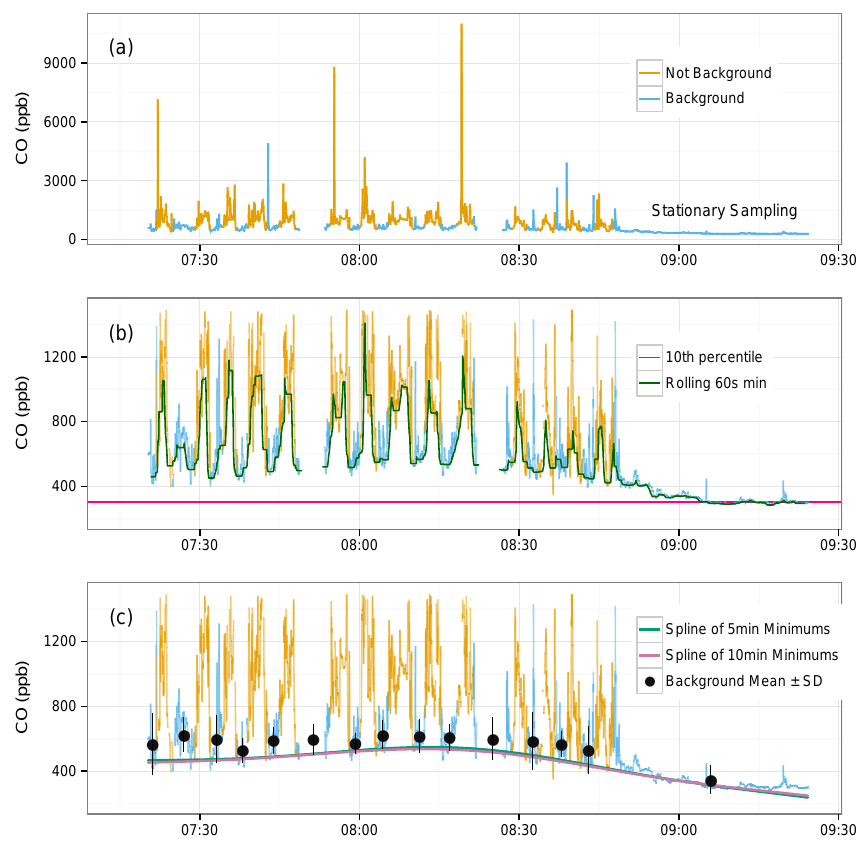
Figure 5. Background estimation methods: (a) example time series; (b) time series methods: running minimum and 10th percentile; (c) location-based method (mean and standard deviation of background areas) and time series methods: spline of 5min minimums and spline of 10min minimums. Gaps in the time series are due to quality control checks. Legend definitions are consistent across panels. The limits of the y axis of (b) and (c) have been reduced to more clearly display the